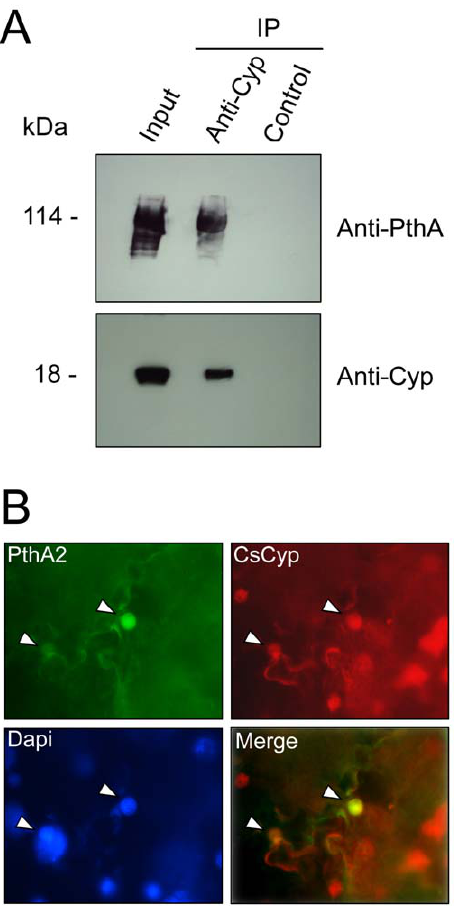
Figure 4. Interaction of PthA2 with CsCyp in plant cells. (A) Immunoprecipitation (IP) assay of PthA2 with the anti-CsCyp serum. Cell extracts of citrus epicotyls transiently expressing PthA2 (input) were incubated with the anti-CsCyp (Anti-Cyp) or the pre-immune serum (control) and protein-A Sepharose. The beads were washed and the bound proteins were resolved on a 13% SDS-polyacrylamide gel and probed with the indicated antibodies. PthA2 was detected in the IP reaction performed with the anti-CsCyp but not with the control pre- immune serum. (B) Co-localization of PthA2 and CsCyp in the nucleus of N. benthamiana cells (arrows). Leaf sectors transiently co-expressing PthA2-GFP (PthA2) and CsCyp-DsRed (CsCyp) were treated with Dapi for 10 min before visualization. Pictures were taken in a Nikon fluorescence microscopy at a 1.000 6 magnification and merged using the software provided by the instrument.